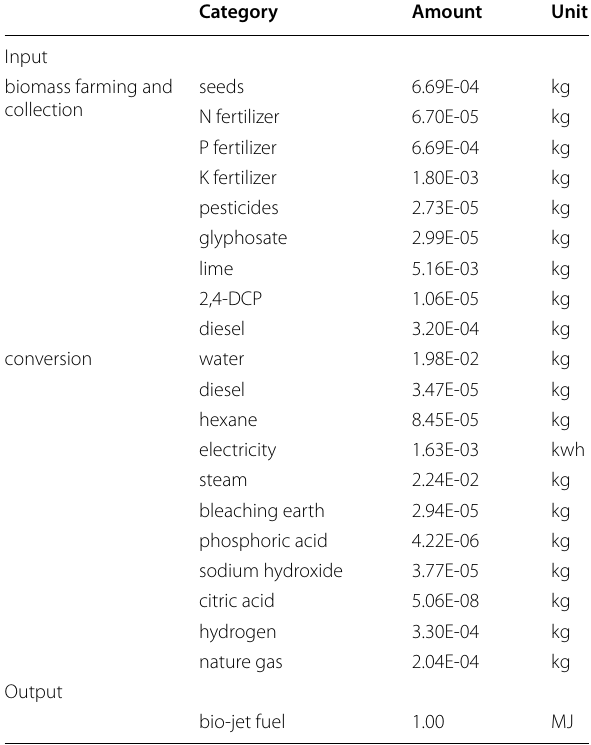
Table 2 LCI for HEFA technical path [27]